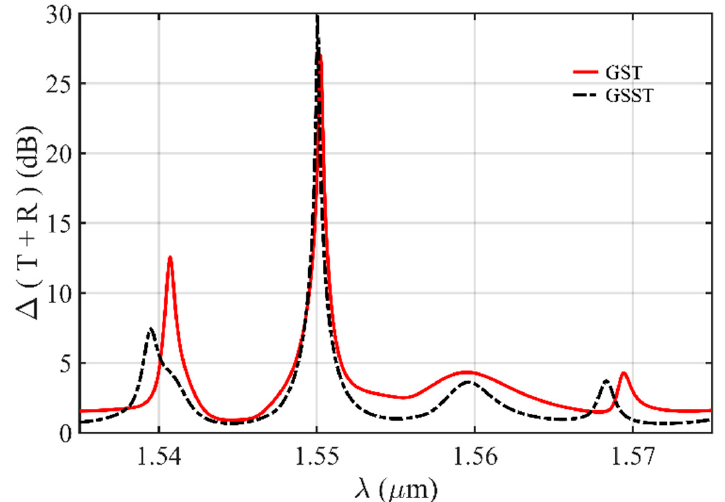
Figure 11. The difference of optical buffering between amorphization and crystallization states of PCM (GST and GSST).